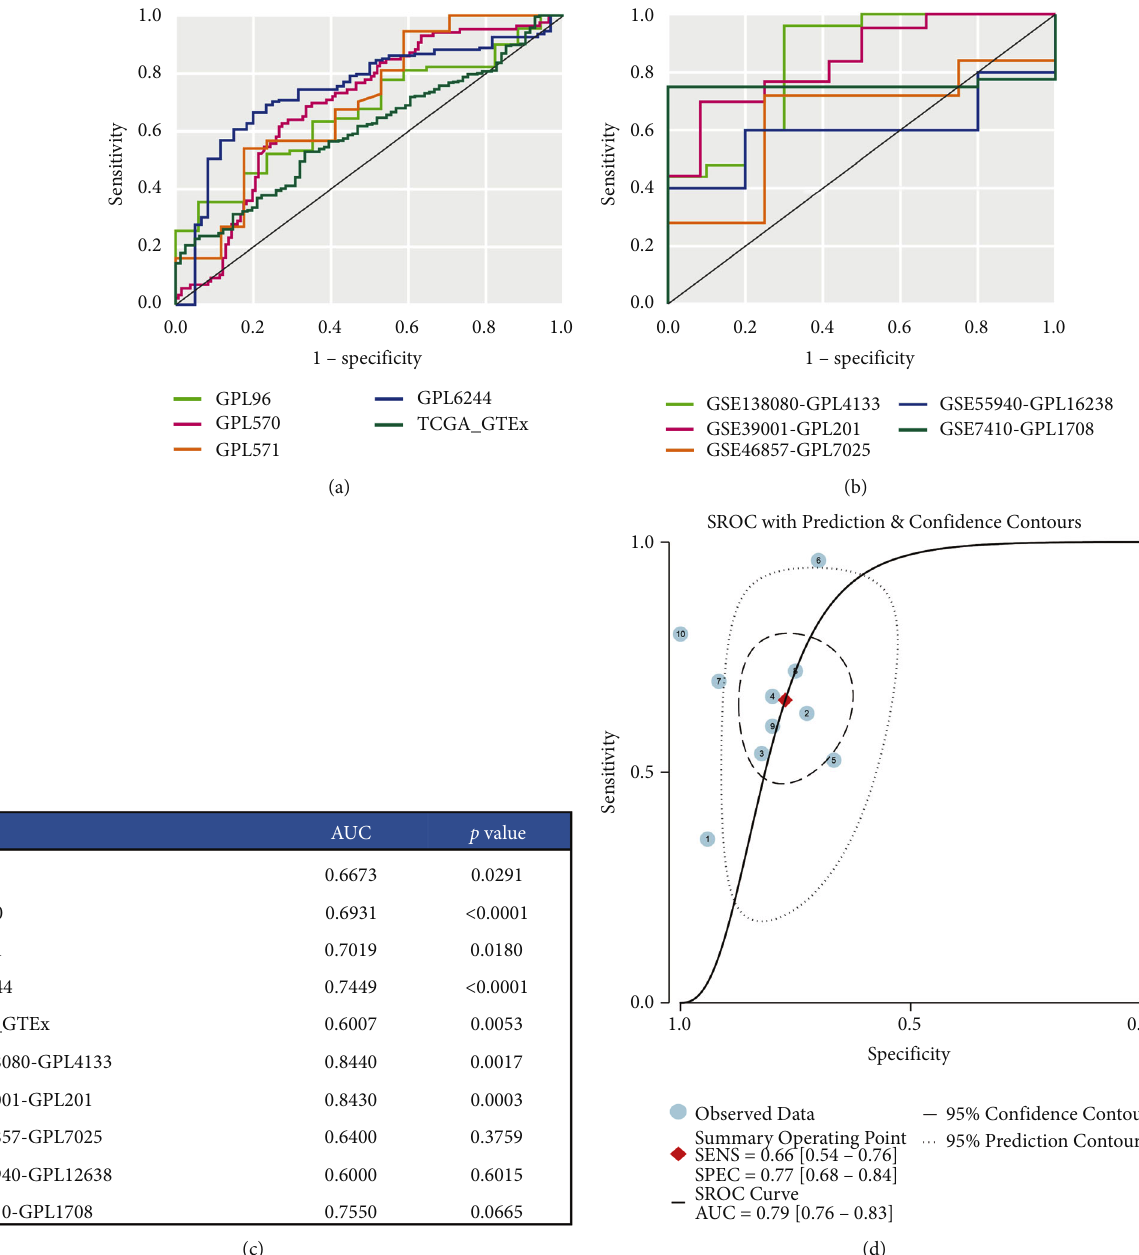
Figure 6: The ability of C1QB to distinguish cervical cancer from normal uterine cervical samples. (a and b) Receiver operating characteristic (ROC) curves, (c) the area under curves (AUC), and (d) summary ROC (sROC) curves for C1QB in cervical cancer. SENS, sensitivity; SPEC, speci fi